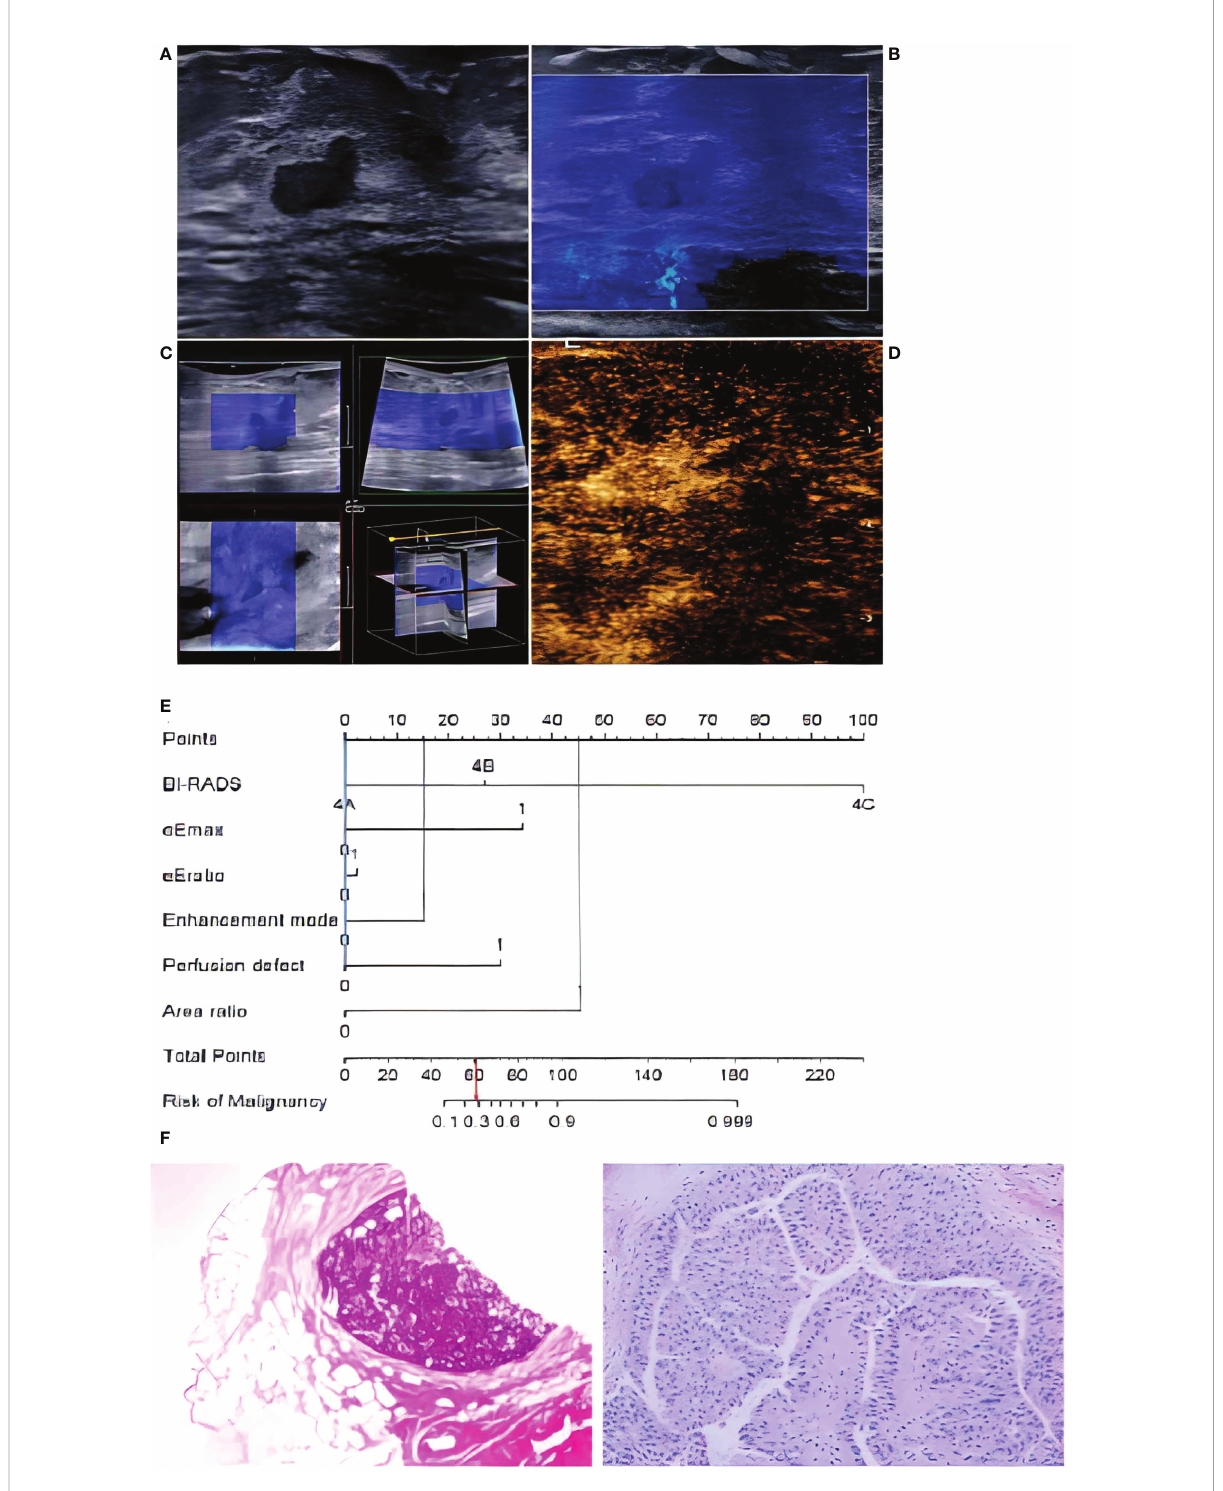
FIGURE 6 In a 72-year-old woman, lesion size was 0.8 x 0.4 cm in the duct on B-mode imaging (A) , considered to be BI-RADS category 4A. The lesion was homogeneously soft (blue color) in 2D-SWE (B) and 3D-SWE (C) , indicating that it was benign. In CEUS (D) , an inhomogeneous hyperenhancement of the lesion was noted, the boundary between the lesion and the surrounding gland was not clear, and the scope was larger than that of the B-mode, indicating malignancy. The risk degree of the nomogram (E) was less than 0.3, indicating a benign neoplasm. Pathology (F) showed that the lesion was intraductal